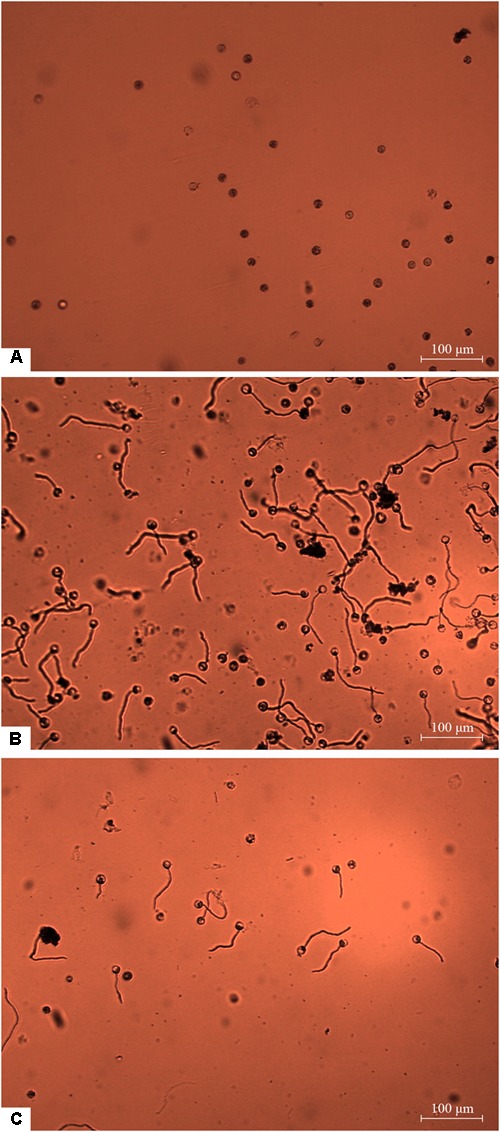
Germination of Phytophthora erythroseptica zoospores. The germination was examined under microscope at 100× magnification at 4 h after treatment. The germ tube longer than half of the spore diameter was considered as germinated. No zoospores germinated at concentration of 1 × 103 spores/ml (A). Zoospores germinated at 1 × 104 spores/ml (B). Zoospores germinated at 1 × 103 spores/ml when suspended in zoospore exudate (ZE) derived from zoospore suspension (1 × 105 spores/ml) (C).